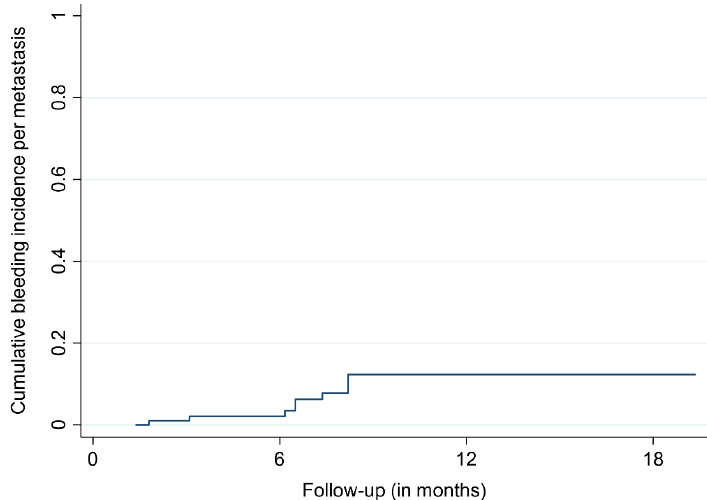
Figure 2. Cumulative incidence of bleeding events per patient.